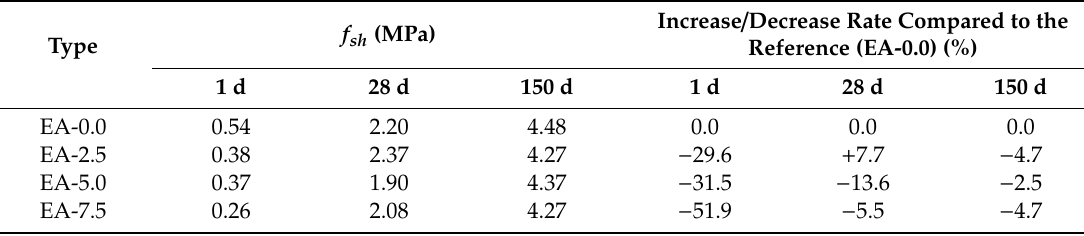
Table 7. Shrinkage stress by age according to expansive additive